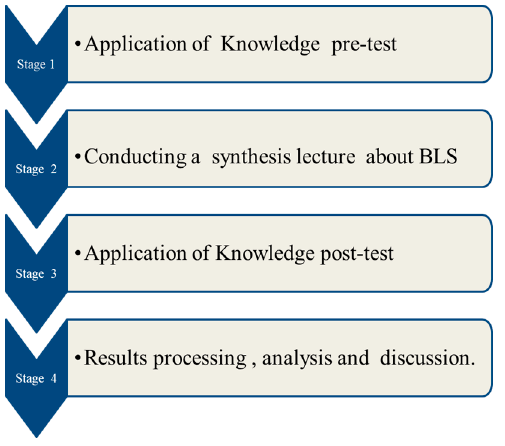
Figure 1. Stages of the research protocol .